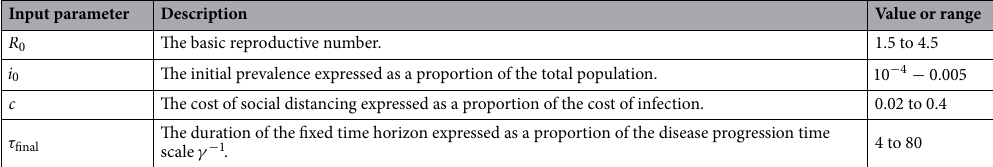
Table 1. Input Parameters and their considered